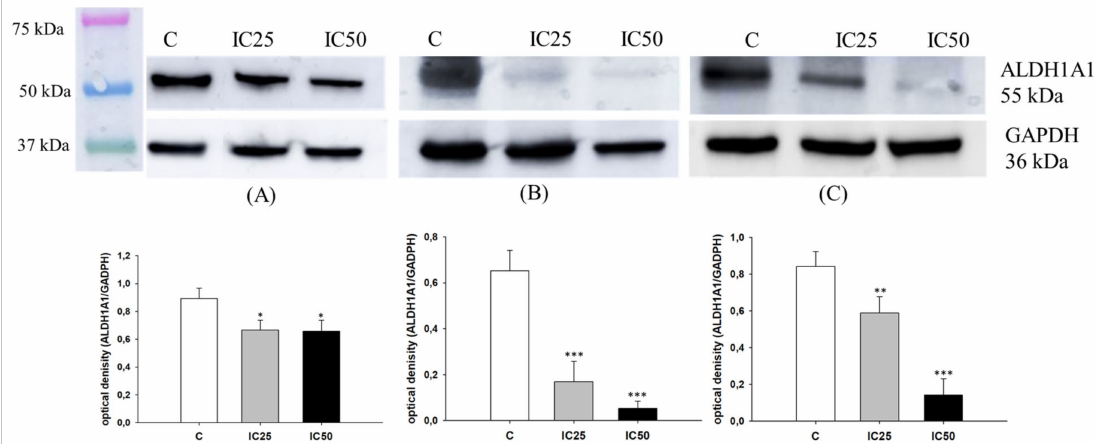
Figure 5. ALDH1A1 protein expression analysis in the W1PR1 ( A ), W1PR2 ( B ), and W1TR cell lines ( C ). Protein lysates were prepared after 72 h of cell culture at piperine concentrations at the IC25 or IC50 along with the control untreated cells ( C ). The cellular proteins were separated using 7% PAGE and transferred to a PVDF membrane, which was then immunoblotted with either primary Ab or HRP-conjugated secondary Ab. A primary anti-GADPH Ab was used as a loading control for the cell lysates. The graphs show the results of the densitometry quantification of the Western blot analysis optical density, which is presented as an ALDH1A1/GADPH ratio. The values were considered significant at * p < 0.05, ** p < 0.01, and *** p <